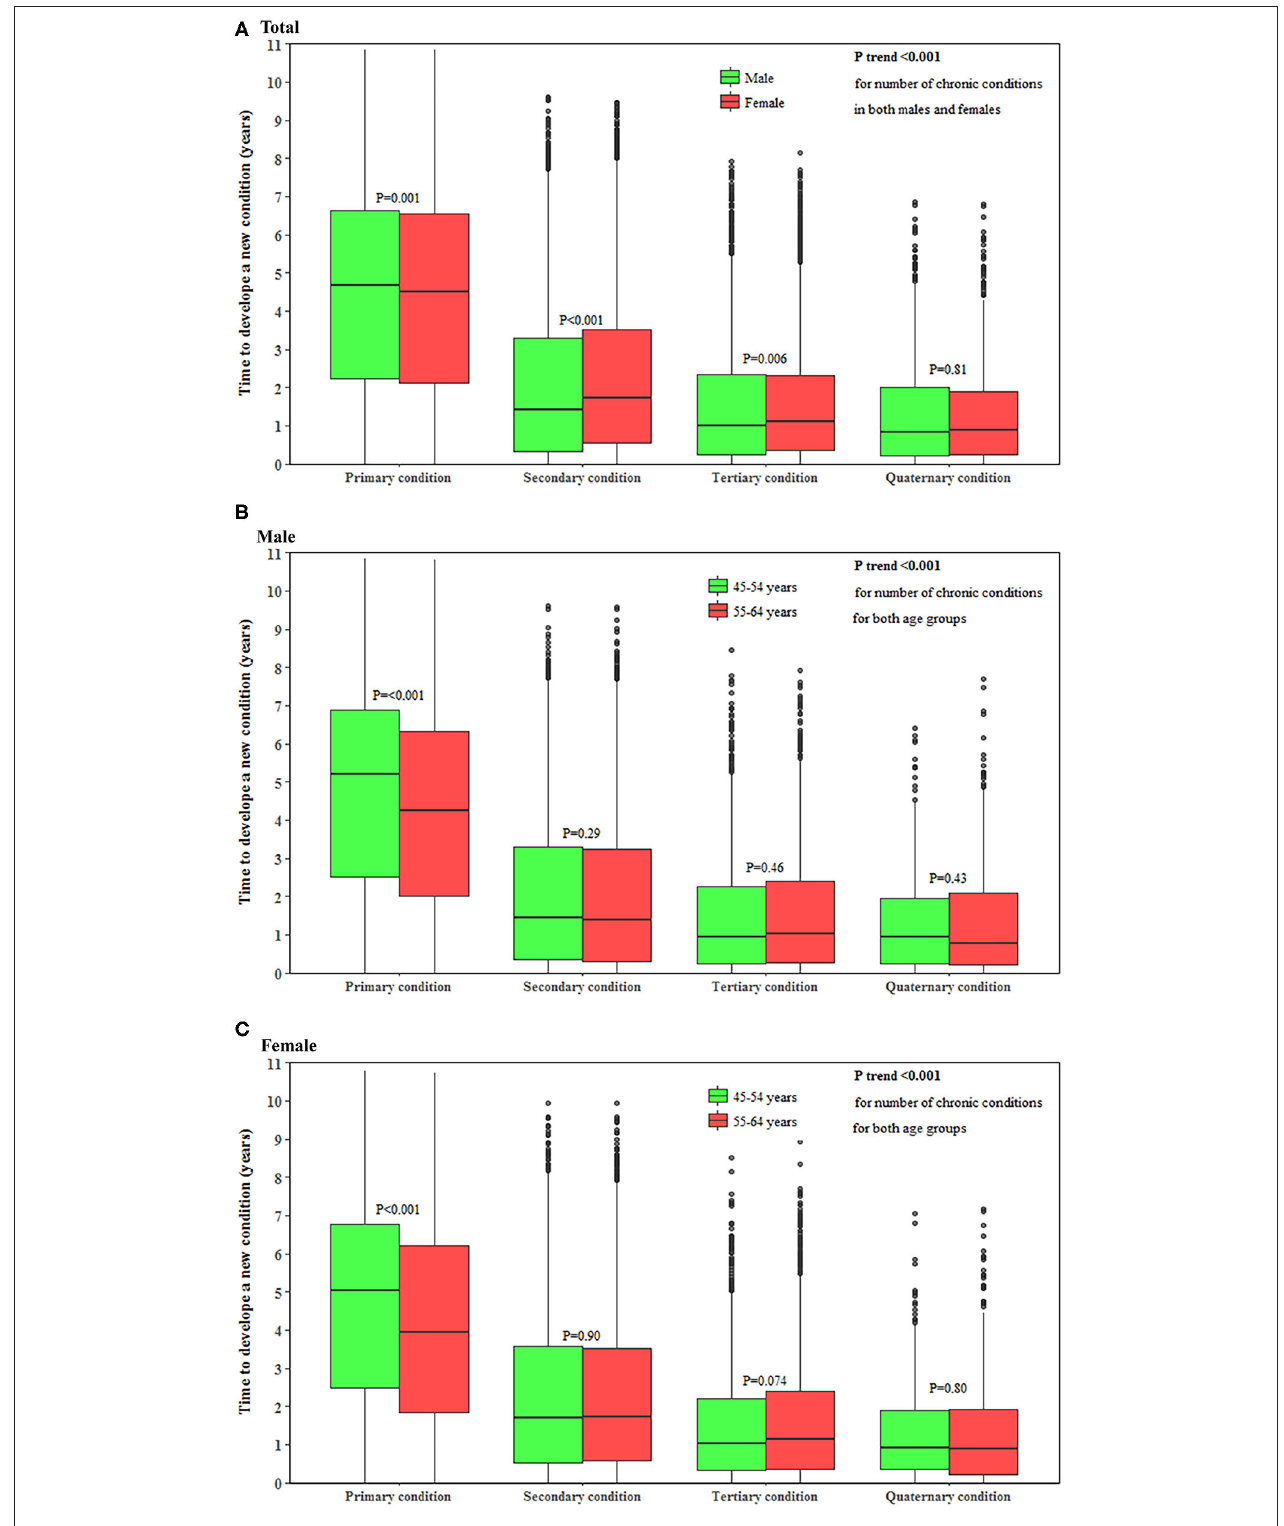
FIGURE 2 | Time to develop a subsequent condition in middle-aged men and women. (A–C) show the time to develop a subsequent chronic condition in total population, men and women, respectively. The horizontal lines that form the top and bottom of the box refer to the 75th percentile (Q3) and 25th percentile (Q1), while the horizontal line in the middle of the box is the median. P -value for the trend of the time to develop a subsequent condition for the accumulation of conditions was computed using the Mann-Kendall test.